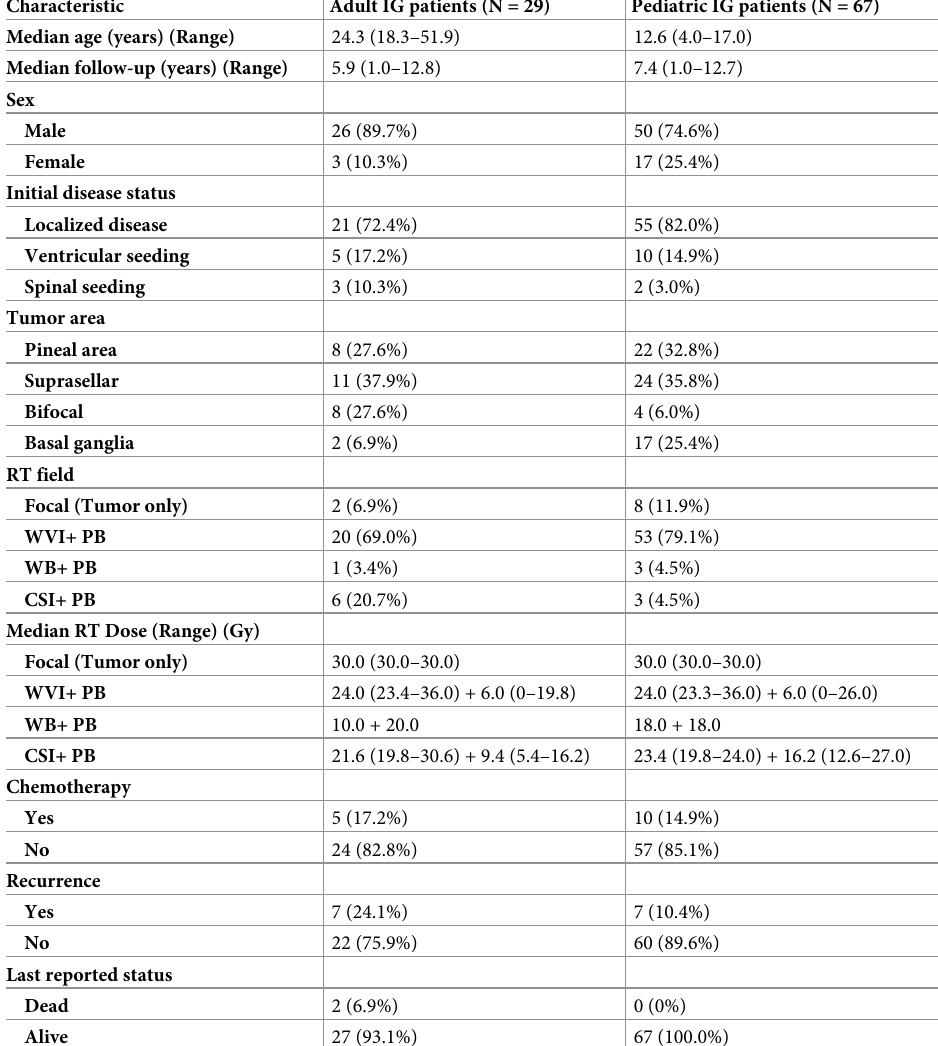
Table 1. Demographic characteristics of adult intracranial germinoma